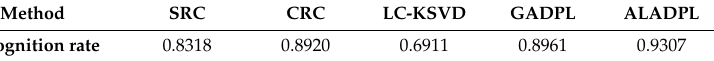
Table 3. The recognition rate obtained in multiclass experiments.